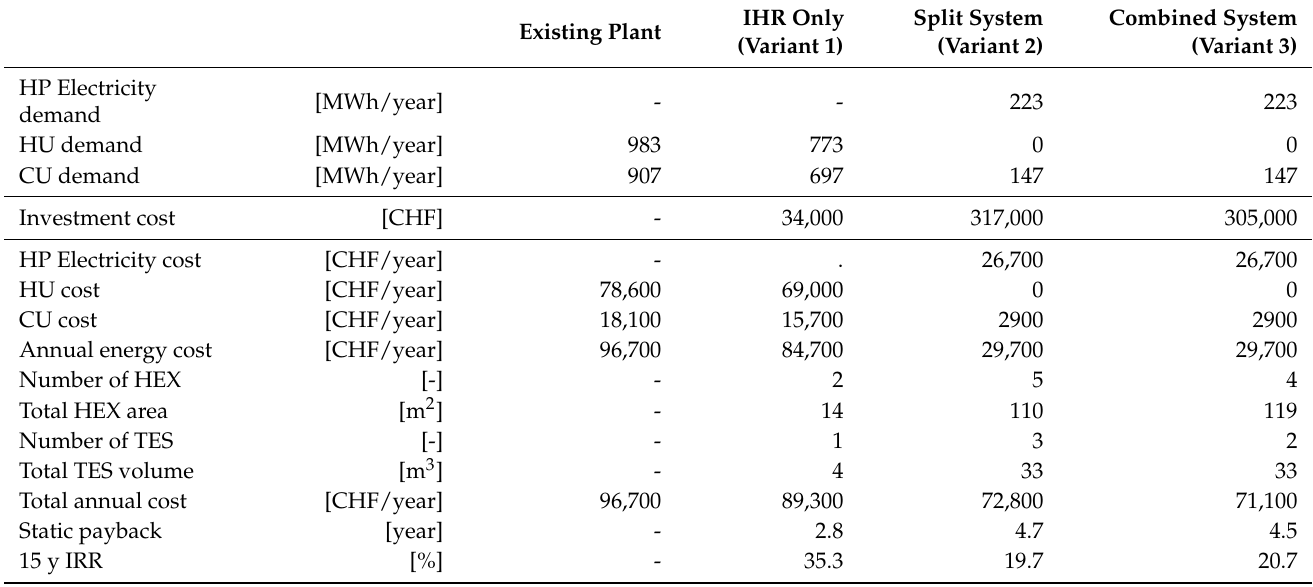
Table 6. Comparison of the energy demand, cost and economic performance of the two variants. IHR Existing Plant